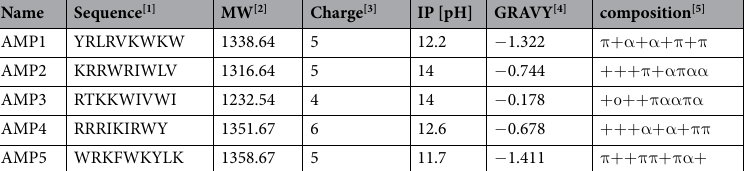
Table 2. Information on tested antimicrobial peptides. [1] N-term: free amine; C-term: carboxamide, [2] Molecular weight [g/mol], [3] Net charge at pH 7 [4] Grand average of hydrophathicity (calculated using online software http://web.expasy.org/protparam) [5] + basic; ο polar; π aromatic; α